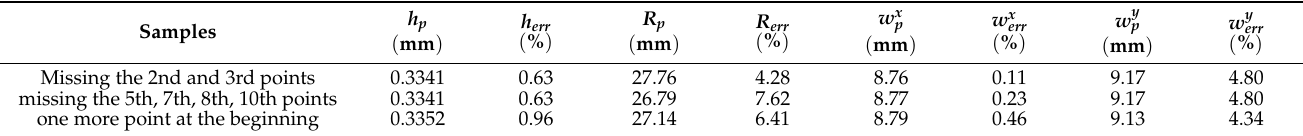
Figure 16. The forward-reverse united optimization results: ( a ) missing the 2nd and 3rd points; ( b ) missing the 5th, 7th, 8th, and 10th points; ( c ) one more point at the beginning. Table 9. The predicted surface parameters of the sample in the three cases.